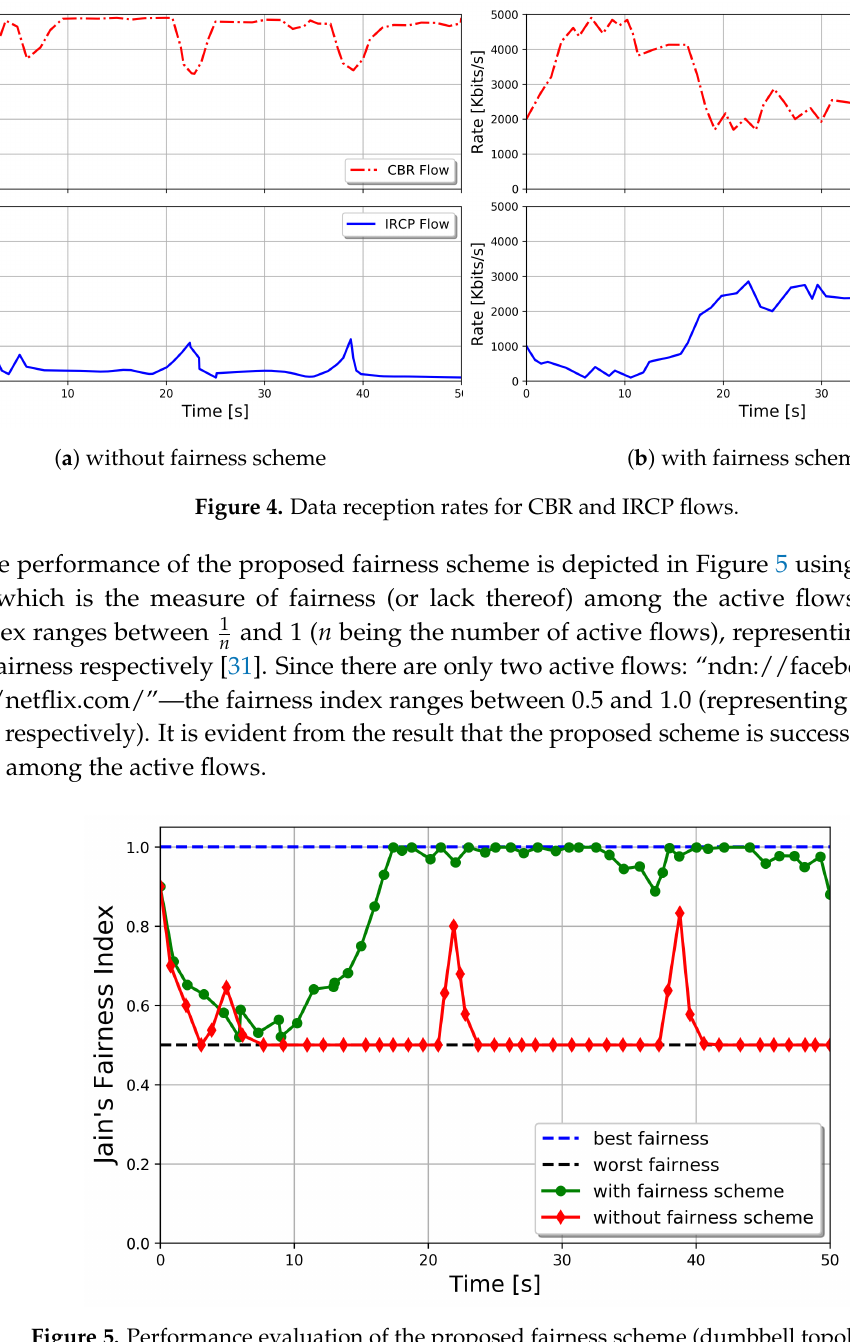
Figure 5. Performance evaluation of the proposed fairness scheme (dumbbell